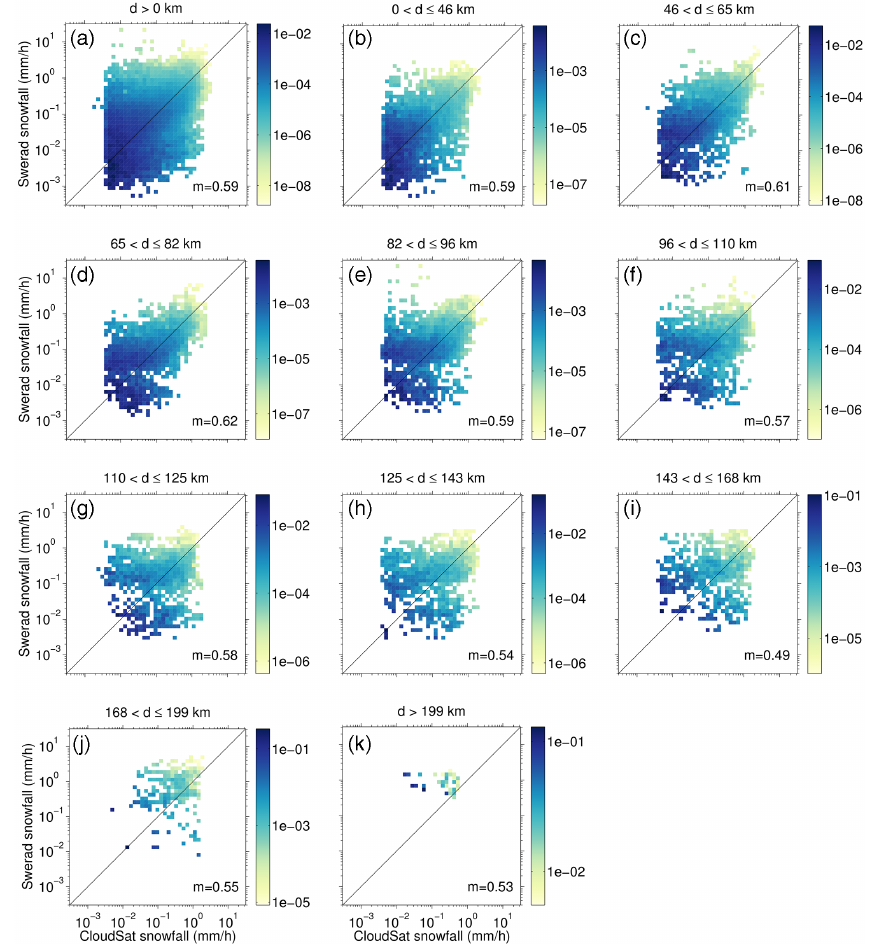
Figure 6. 2-D probability density functions (PDFs) of observational pairs of snowfall by CloudSat and Swerad. Panel (a) shows the 2-D PDF for all observational pairs, whereas panels (b–k) show the 2-D PDF for various distances to the nearest ground-based radar. Note the logarithmic scales. The metric m estimates how well the observations agree (0 ≤ m ≤ 1, where m = 1 is perfect